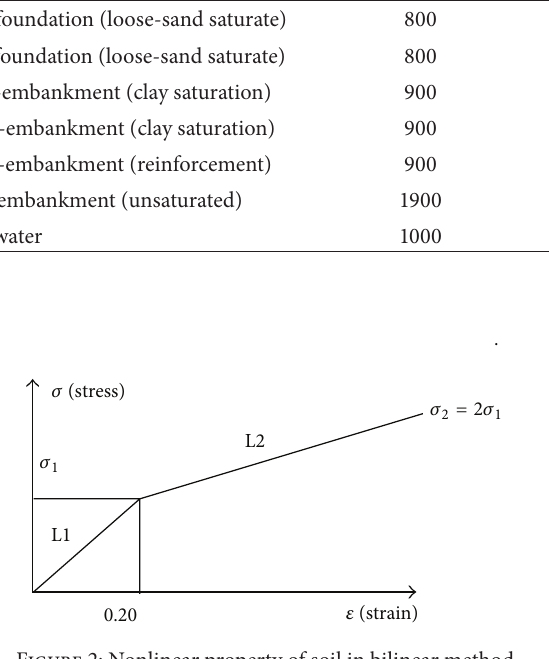
Figure 2: Nonlinear property of soil in bilinear method.